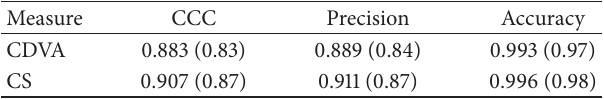
Table 1: Agreement indices for measurement of CDVA and CS by Thomson and MiQ devices.